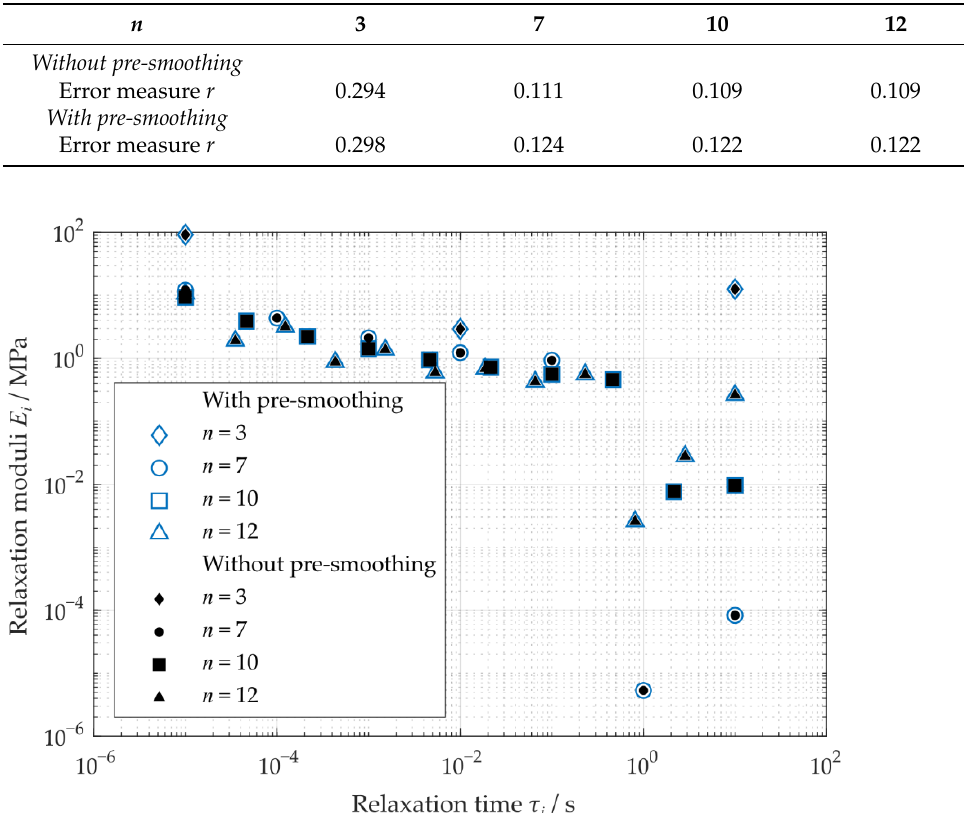
Table 2. Resulting error measure of the approximated storage and loss modulus.